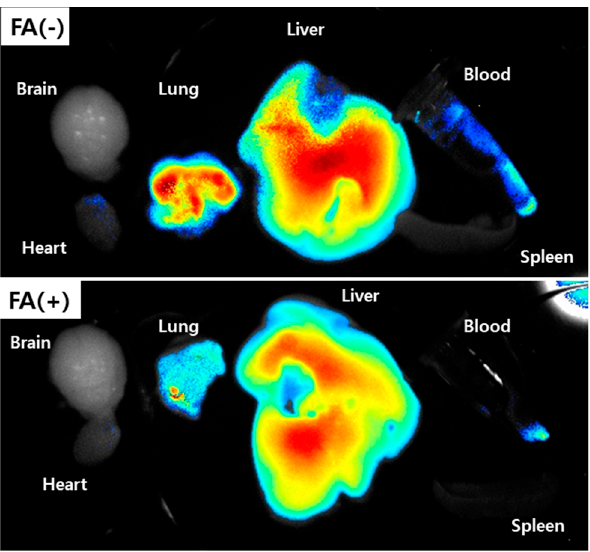
Figure 7. Pulmonary metastasis of KB cells. To block folate receptor of KB cells, folic acid in PBS (dose: 20 mg/kg) was i.v. administered 1 h before injection of nanophotosensitizer. 1 × 10 6 KB cells were intravenously i.v. administered via the tail vein of nude BALb/C mouse. Three weeks later, nanophotosensitizers (dose: 10 mg/kg) were i.v. administered via the tail vein of the mouse. To block folate receptor (FA(+)), folic acid in PBS (dose: 20 mg/kg) was i.v. administered 1 h before nanophotosensitizer administration. PBS without FA was i.v. administered for comparison (FA(-)). To observe fluorescence images of each organ, the mice were sacrificed 24 h later.